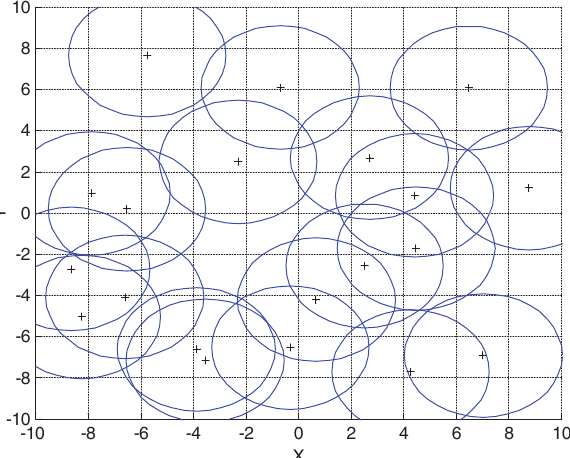
Figure 7: The Node Layout When the Iteration Number Was